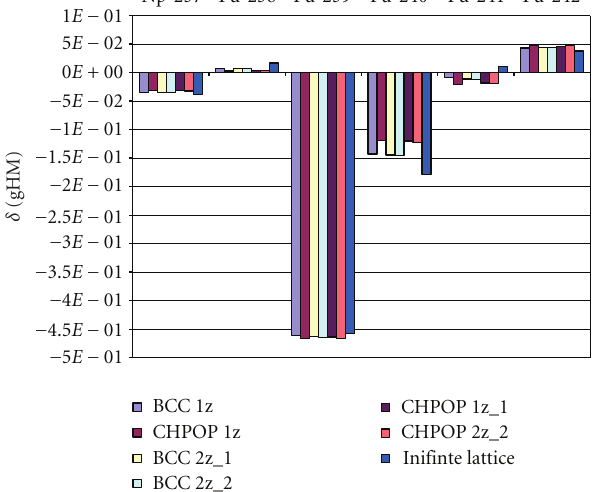
Figure 5: Production (grams) of Pu nuclides per initial HM mass in the di ff erent PBMR core models (after 1063 EFPD).